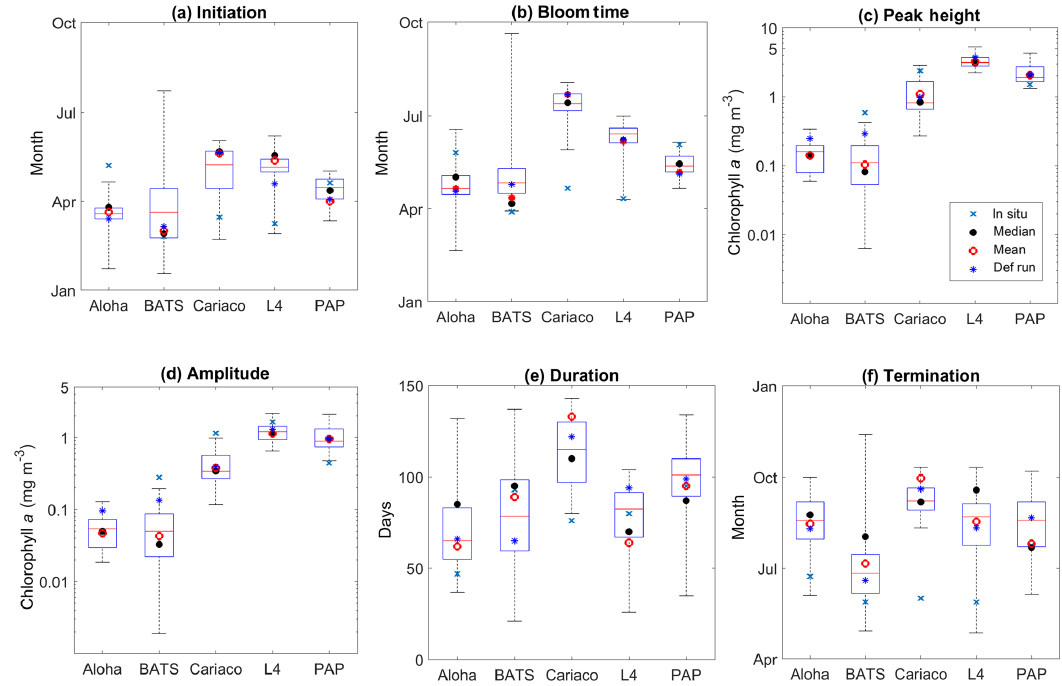
Figure 15. Phytoplankton phenology metrics at the five stations. The blue cross is the in situ observation; the red, black, and blue dots are the ensemble mean, median, and the default run respectively. The timings and concentrations are averaged annually from January 1998 to December